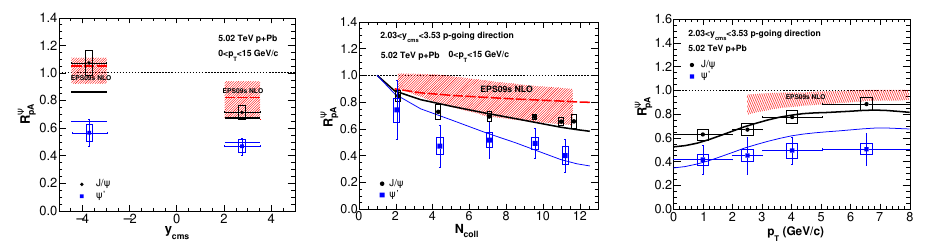
Figure 2. (Color online) J /ψ and ψ (2 S ) nuclear modification factors as a function of rapidity, number of binary collisions (centralities), transverse momentum respectively at √ s NN = 5 . 02 TeV p-Pb collisions. The band only includes shadowing e ff ects. Lines are the full calculations with both cold and hot medium e ff ects for J /ψ and ψ (2 S ). These figures are cited from [24].